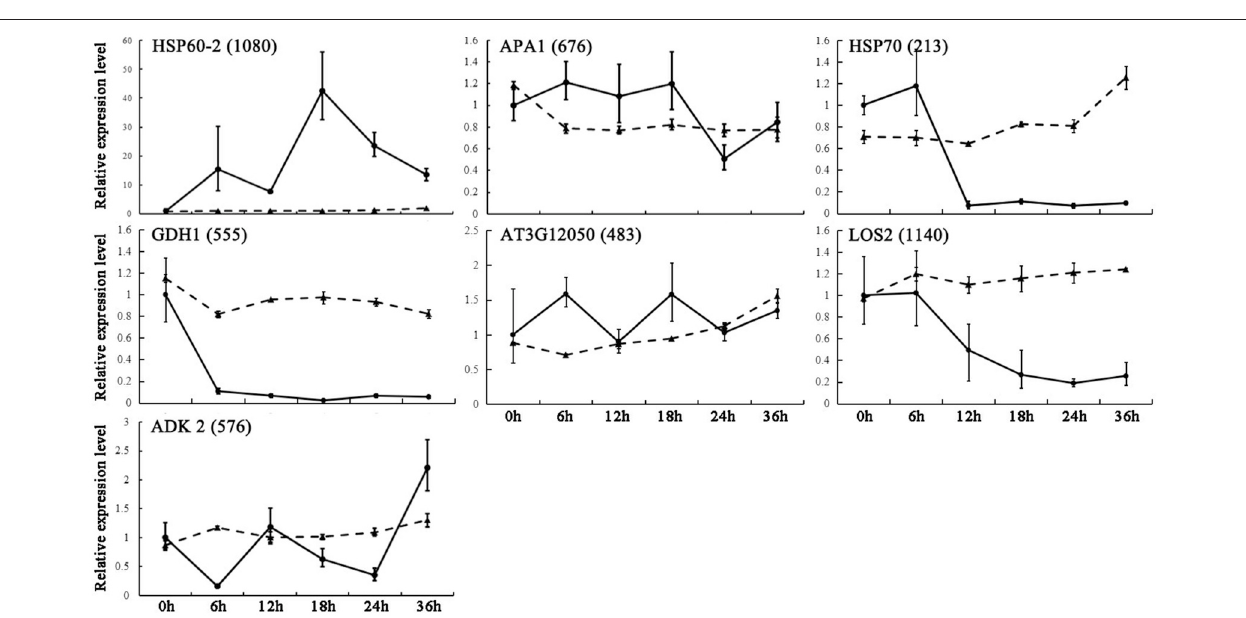
FIGURE 7 | qRT-PCR analysis of gene expression patterns in germinating seeds. Relative expression levels of homologous genes of DEPs from B. napus seeds were determined by qRT-PCR analysis. The value were determined 0, 6, 12, 18, 24, and 36 HAI and are presented as means ± standard error ( n = 3). Different lines show relative expression levels of homologous genes (solid line) and corresponding proteins (dotted line).